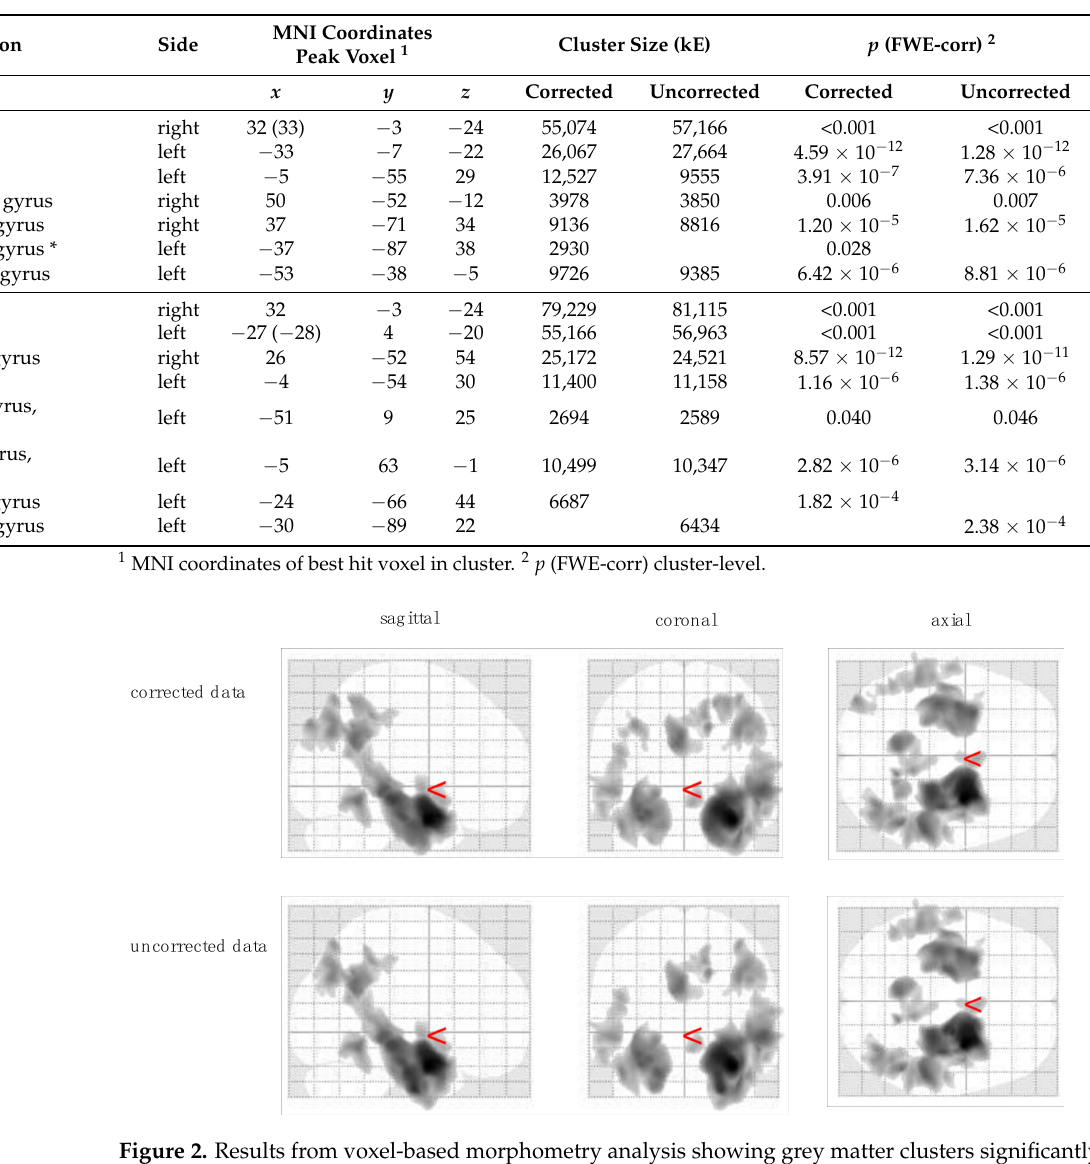
Table 2. Grey matter voxels with significant correlation with ( a ) CVLT_1–5 and ( b ) CVLT_LDFR performance and their anatomical locations (Regions determined using MRIcron aal template) for the corrected and uncorrected data set, respec- tively. Different results in coordinates between the two data sets are displayed by numbers in brackets, whereas the coordinates for the uncorrected data set are enclosed. Missing values in cluster size and p value represent a voxel that appeared significant only in the corrected or uncorrected sample. Anatomical regions with asterisk (*) are undefined voxels in the aal template, and the regions are defined according to neighboring voxels.